Question: Write a single sentence explaining what this figure depicts.
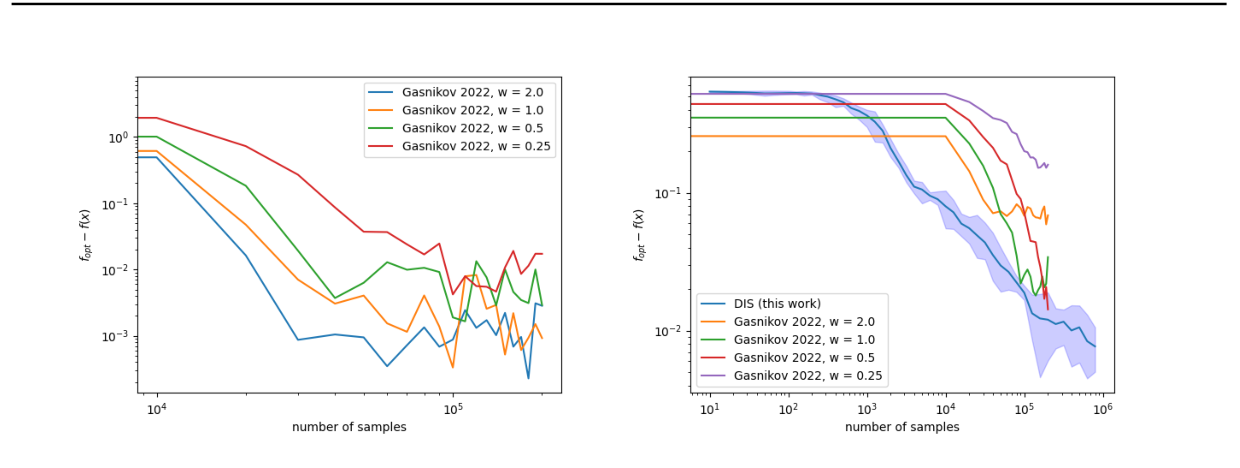
Answer: Left: Distance from true optimum plotted against the number of oracle calls for the algorithm analyzed in (Gasnikov et al.,